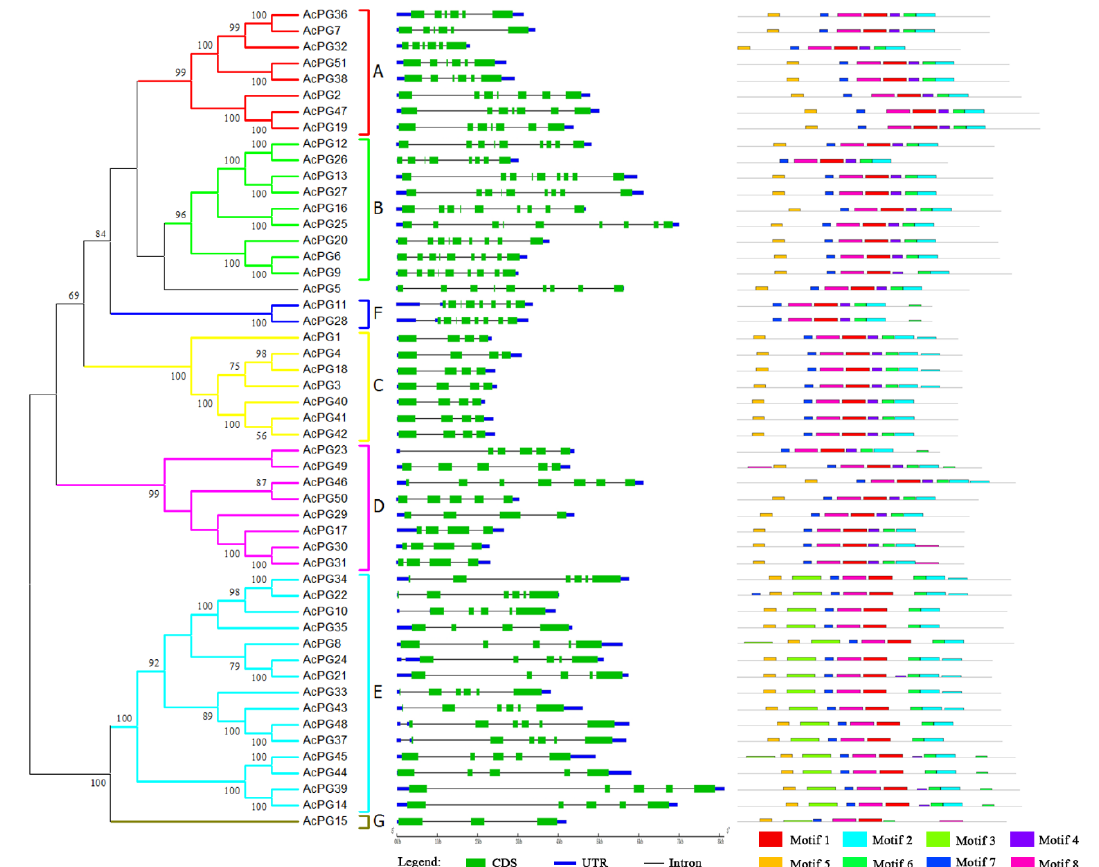
Figure 3. Phylogenetic tree, genomic structure and conserved motif analysis of kiwifruit PG genes. The left illustrates the phylogenetic tree of kiwifruit PG genes constructed using MEGA 6.0 by the Neighbor-Joining method with the 51 full-length protein sequences of AcPGs . Numbers on branches indicate bootstrap percentage values calculated from 1000 replicates, and values lower than 50 are not shown. Seven clade (A to G) are distinctly formed in the phylogenetic tree. The middle represents the exon/intron genomic structure of AcPGs . CDS and UTR are indicated by green and blue boxes, respectively, and intron by black line. Their sizes can be estimated using the length scale at the bottom. The right indicates the composition and position of the conserved motifs of AcPGs . Eight conserved motifs identified by MEME are indicated by different colored boxed. The height of each box represents the conservation of each motif.